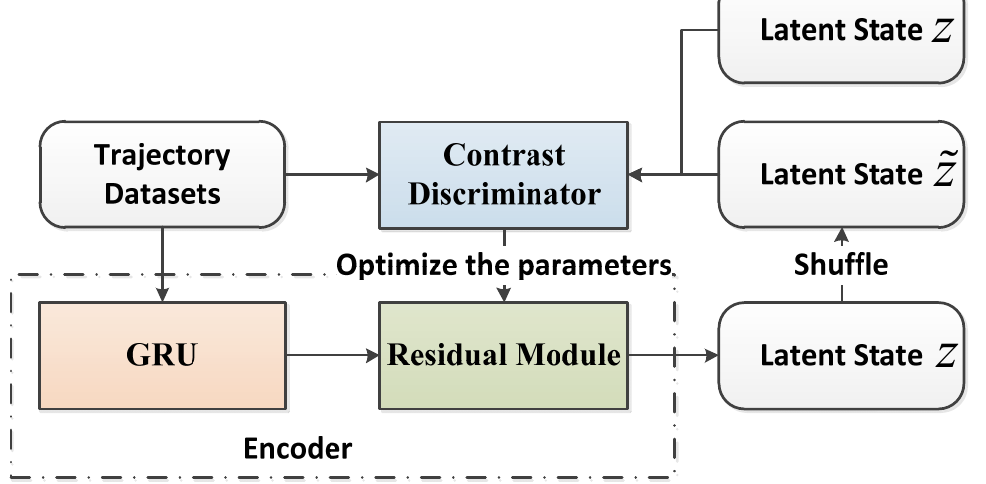
Figure 4. The potential features with an unsupervised cluster module.